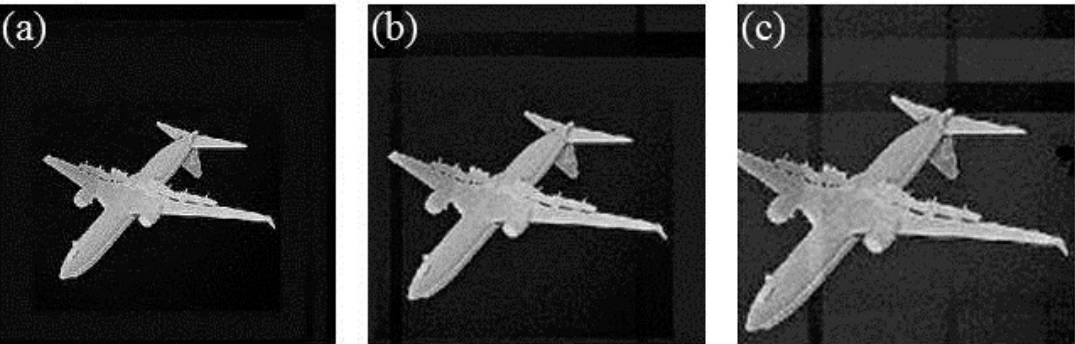
Figure 7. Image reconstruction result of digital simulation experiment when ( a ) △ u = 0.33, N ap = 200; ( b ) △ u = 0.40, N ap = 166; ( c ) △ u = 0.50, N ap = 134.